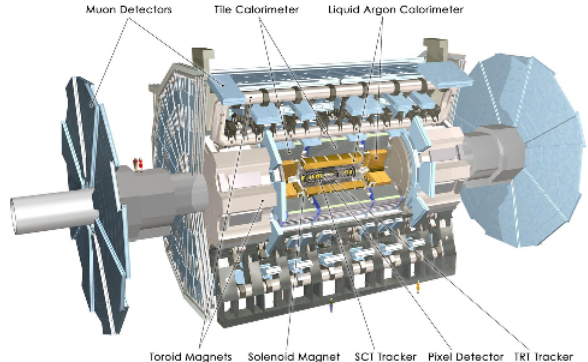
Fig. 1. The ATLAS